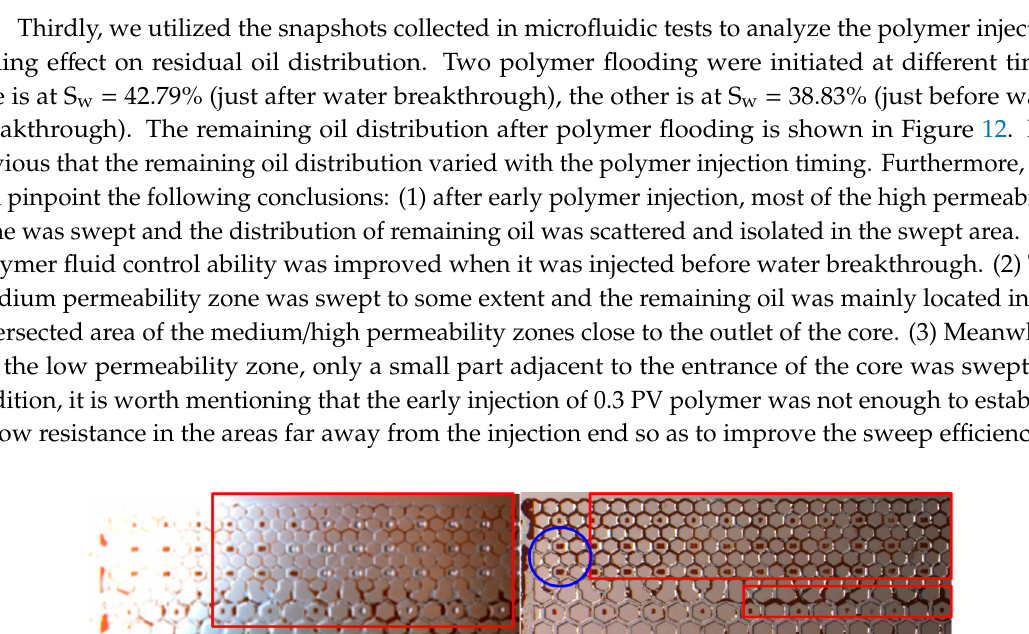
Figure 11. Distribution of remaining oil before and after injection of 0.104 PV water.